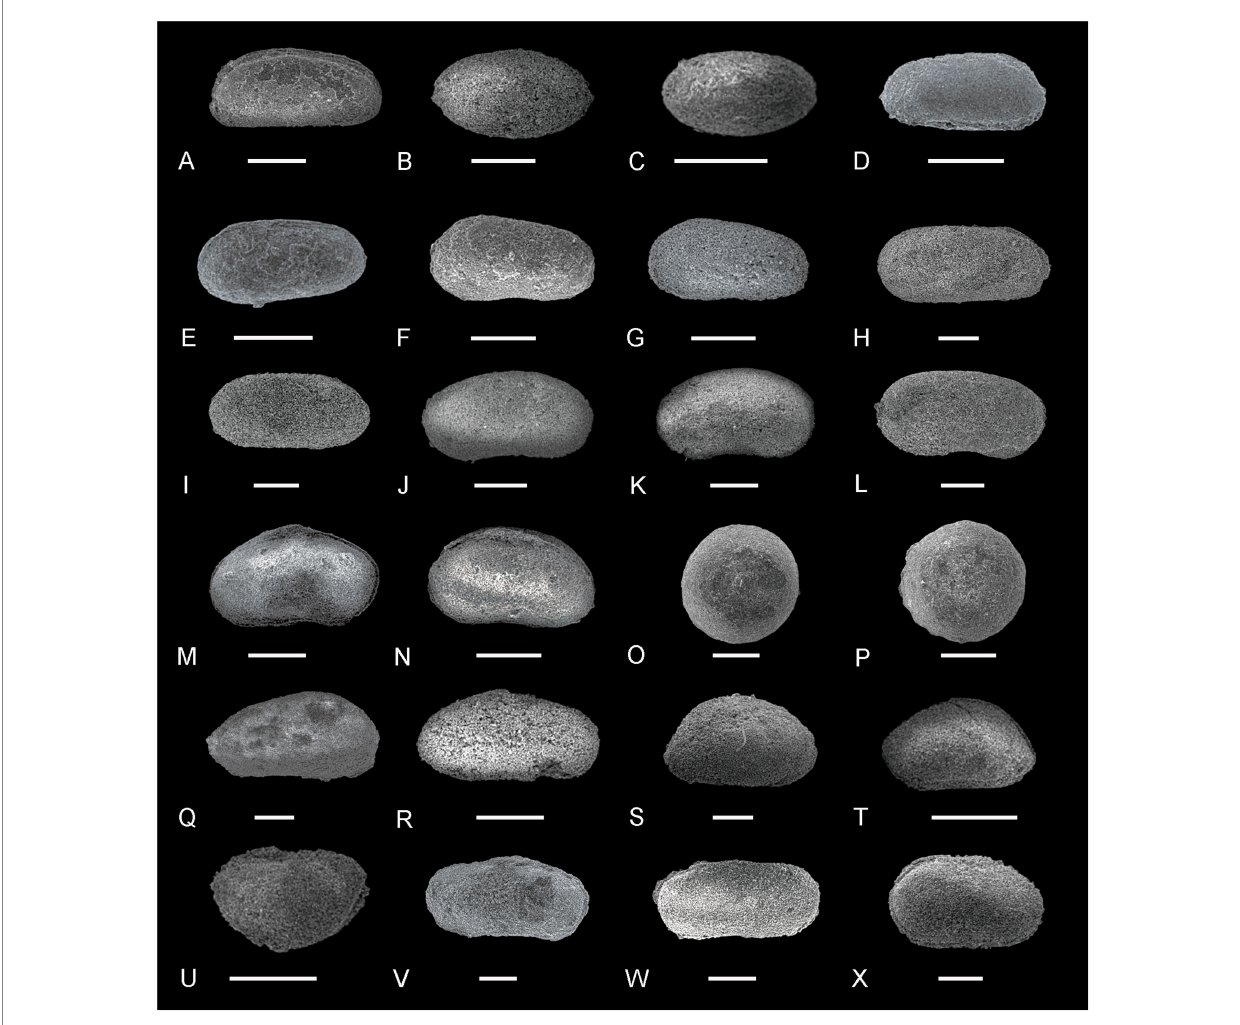
FIGURE 5 Ostracods from the Youping Section (III). (A) Microcheilinella peraxilis Shi, left lateral view, sample YP-18; (B,C) Microcheilinella sp., right lateral view, sample YP-7 and YP-9; (D,E) Paracypris gaetanii Crasquin-Soleau, D : right lateral view, sample YP-19; E : left lateral view, sample YP-19; (F,G) Paracypris sp. 2, left lateral view, sample YP-9; (H,I) Paracypris sp. 1, H : left lateral view, sample YP-16; I : right lateral, sample YP-16; (J–L) Praezabythocypris ottomanensis Crasquin-Soleau, right lateral view, J,K : sample YP-13; L : sample YP-16; (M,N) Prazathocypris cf. pulchraformis Forel, M : right lateral view, sample YP-19; N : left lateral view, sample YP-19; (O,P) Polycope sp., right lateral view, sample YP-3; (Q) Rectobairdia cf. tantilla Kummerow, right lateral view, sample YP-18; (R,S) Silenites sasakwaformis Shi, right lateral view, sample YP-13 and YP-15; (T) Silenites lenticularis Knight, right lateral view, sample YP-15; (U) Smarella meishanella Forel, left lateral view, sample YP-15; (V,W) Sulce suprapermianana Kozur, right lateral view, sample YP-17 and YP-19; (X) Volganella minuta Wang, left lateral view, sample YP-15. Scale bars = 200 μ